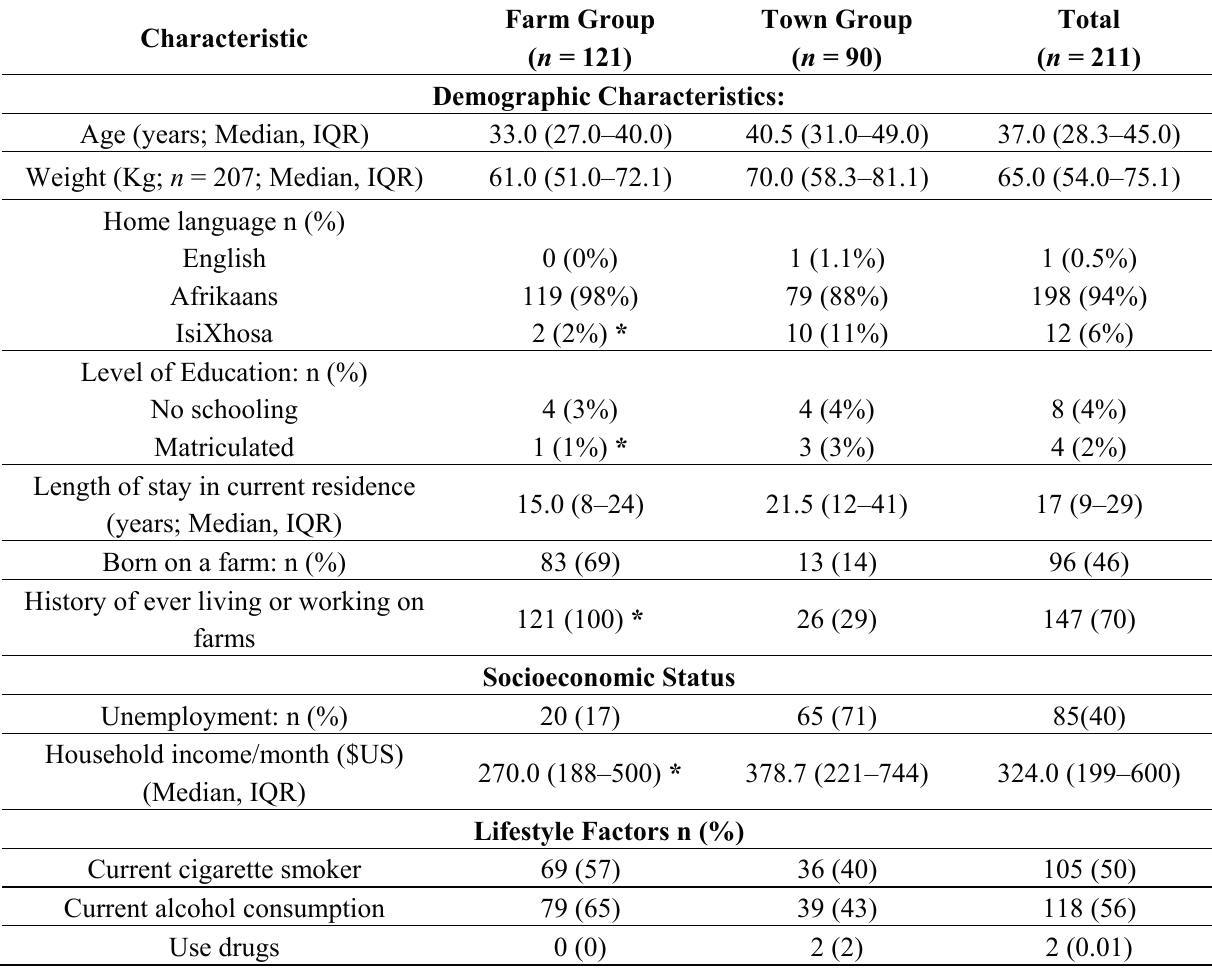
Table 1. Demographic information, socio-economic status, living and working history and lifestyle factors of participants in the